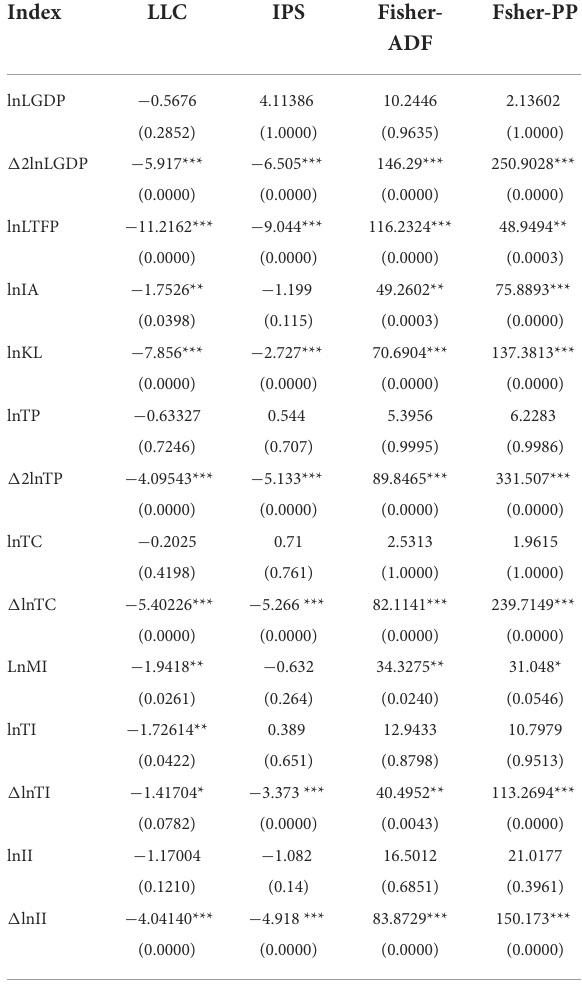
TABLE 3 Results of stationarity test for each index sequence.